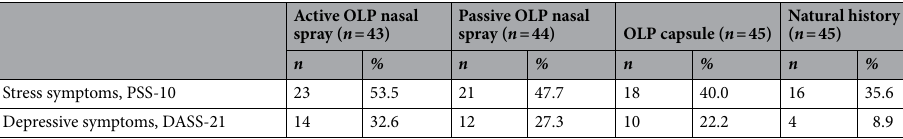
Table 3. Number of participants with Reliable Change Index (RCI) > 1.96 as measure of reliable change in stress symptoms and depressive symptoms per group. n number of participants; PSS-10 Perceived Stress Scale; DASS-21 Depression Anxiety and Stress Scale.